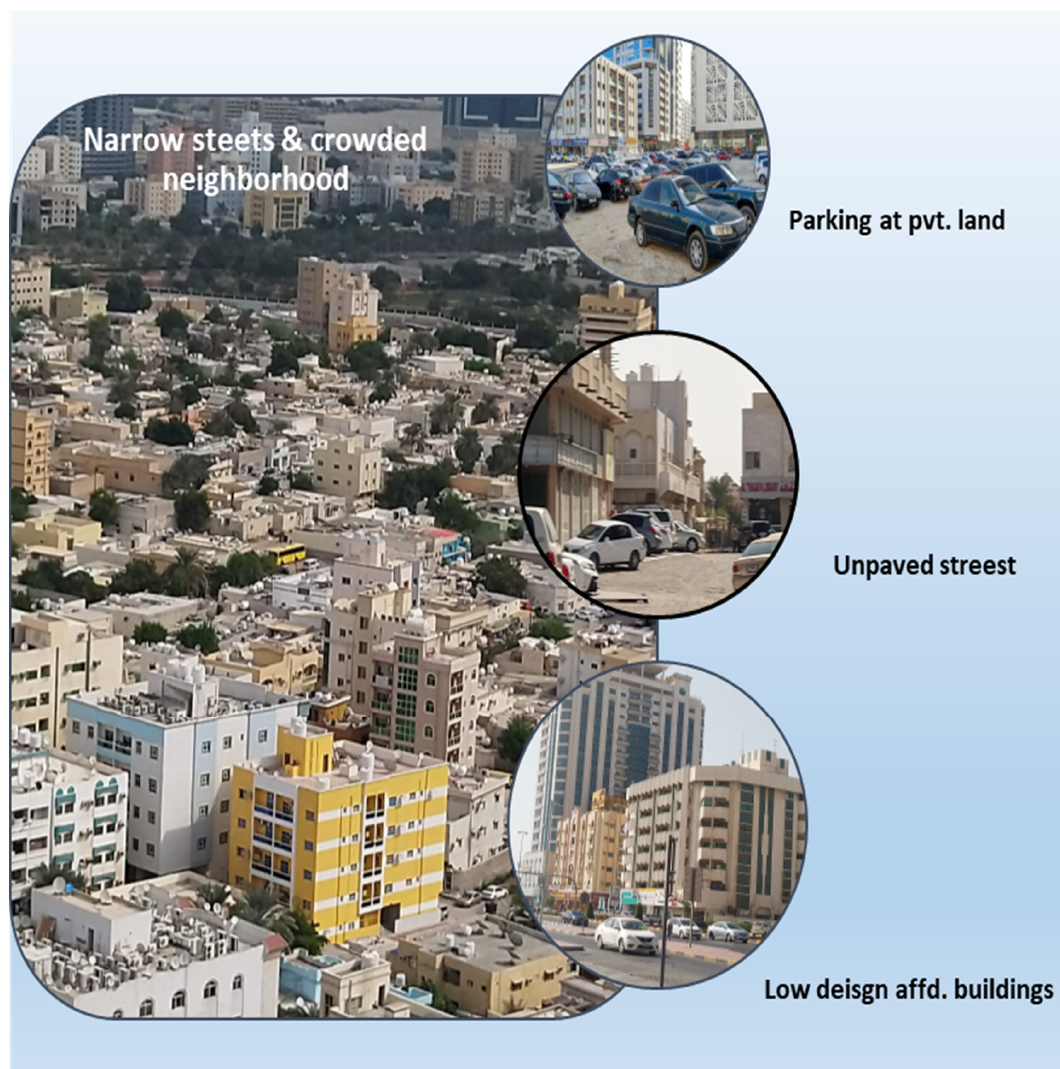
Figure 2. Site and neighbourhood issues.